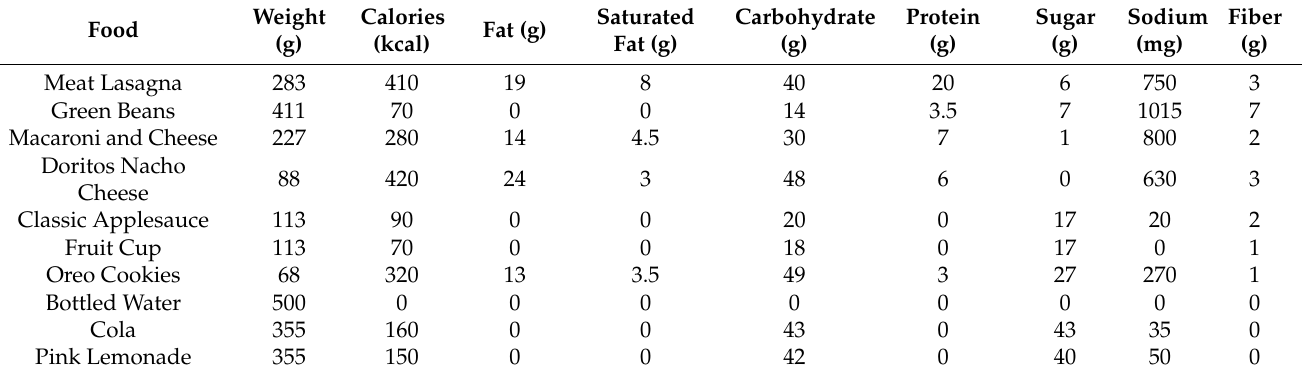
Table A1. Nutritional Composition of Ad Libitum Lunch Foods.